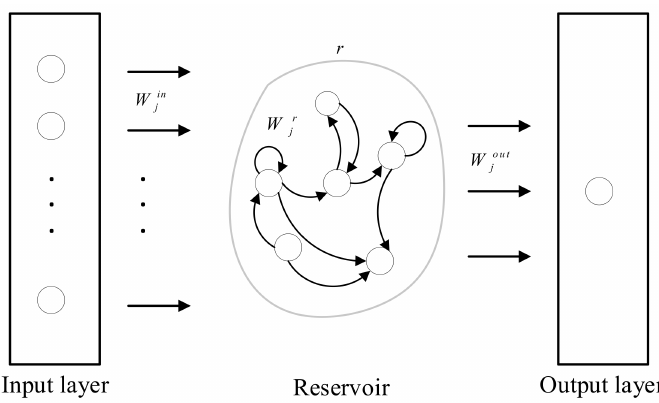
Figure 4. Structure of water quality prediction model based on